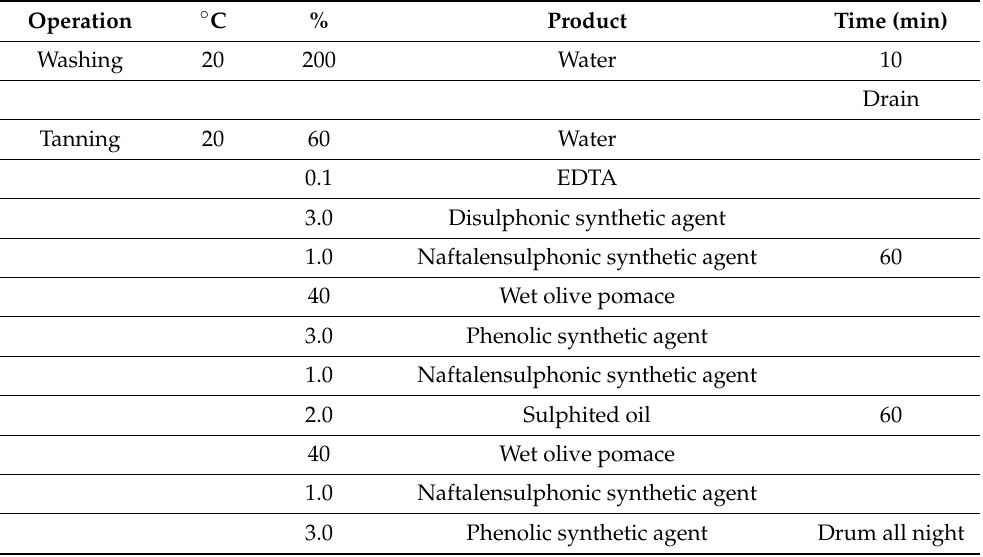
Table 1. Formulation for WOP